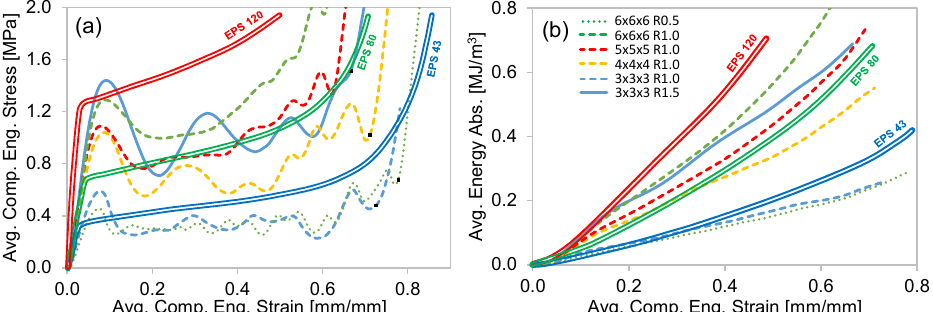
Figure 12. A comparison of the ( a ) stress–strain and ( b ) EA characteristics between Resin 2 octet- trusses and EPS foams. The legend is common to both graphs. The EPS foam values were digitized and computed from [27].